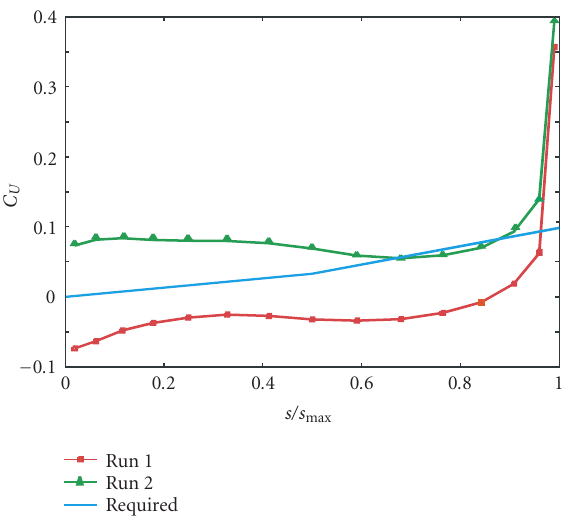
Figure 10: Outlet circumferential velocity distribution for the first and second optimization runs compared with the required distri- bution.